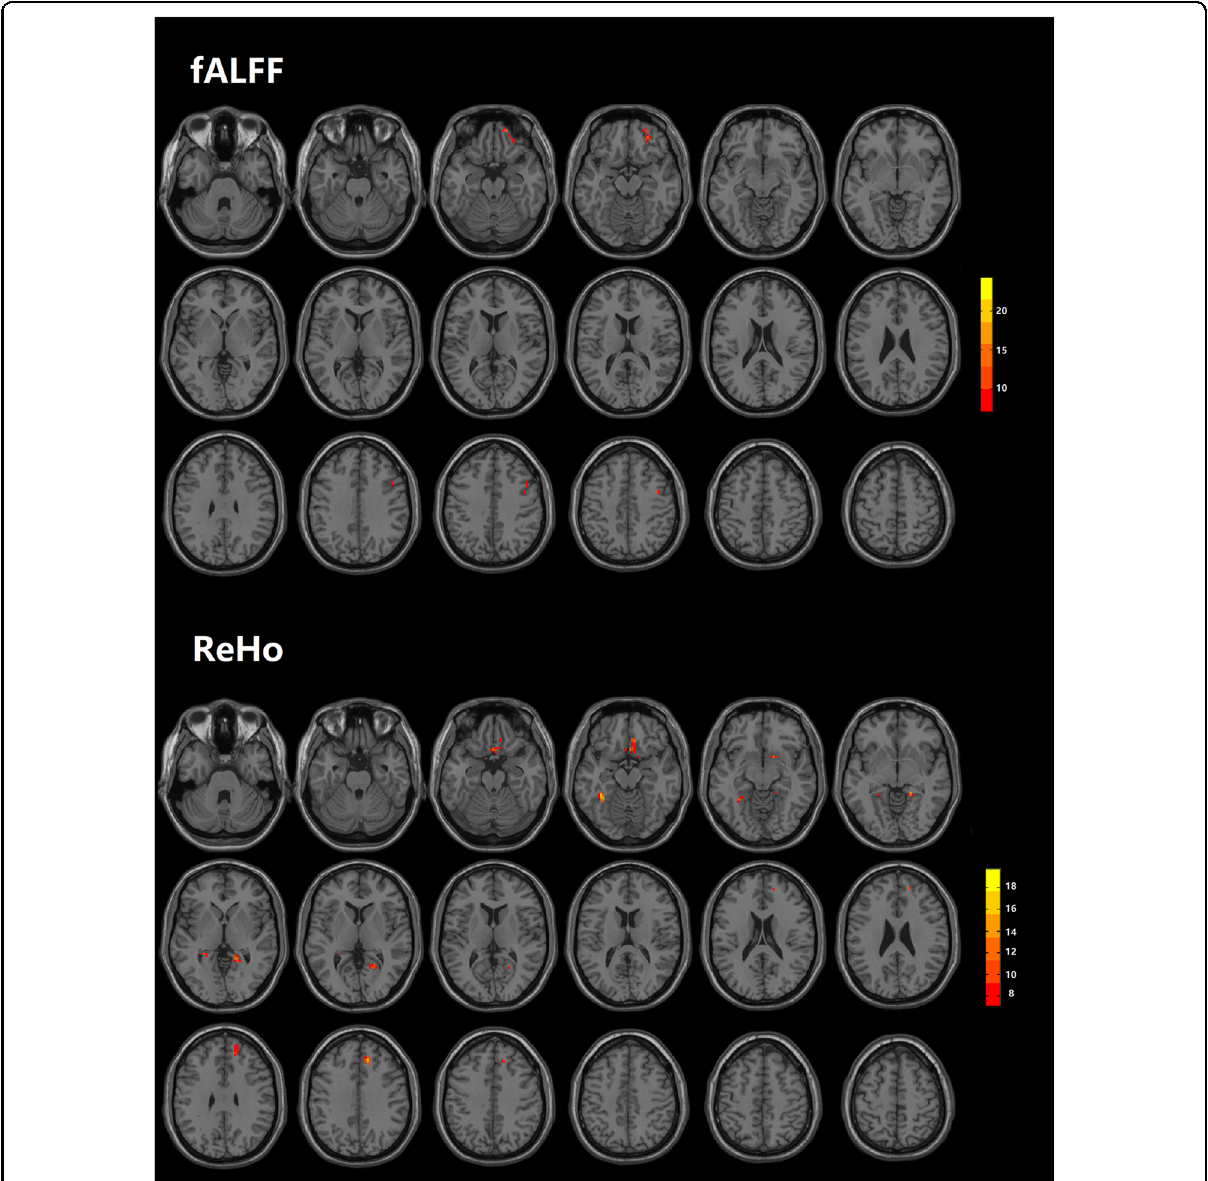
Fig. 2 Additive effects between LLD and OI dysfunction on fALFF and ReHo. Two × two factorial analyses were used to analyze the in fl uence of the factor “ Depression ” (LLD and NC) and factor “ Olfaction ” (OI dysfunction and intact OI) on fALFF and ReHo, and control variables included age, sex, years of education, and gray matter images. Multiple comparison correction was performed using a false discovery rate (FDR) at P < 0.05. The color scale bar shows the logarithmic scale of p -values ( − log10). The closer to yellow, the more signi fi cant the difference between groups. fALFF, fractional amplitude of low-frequency fl uctuation; ReHo, regional